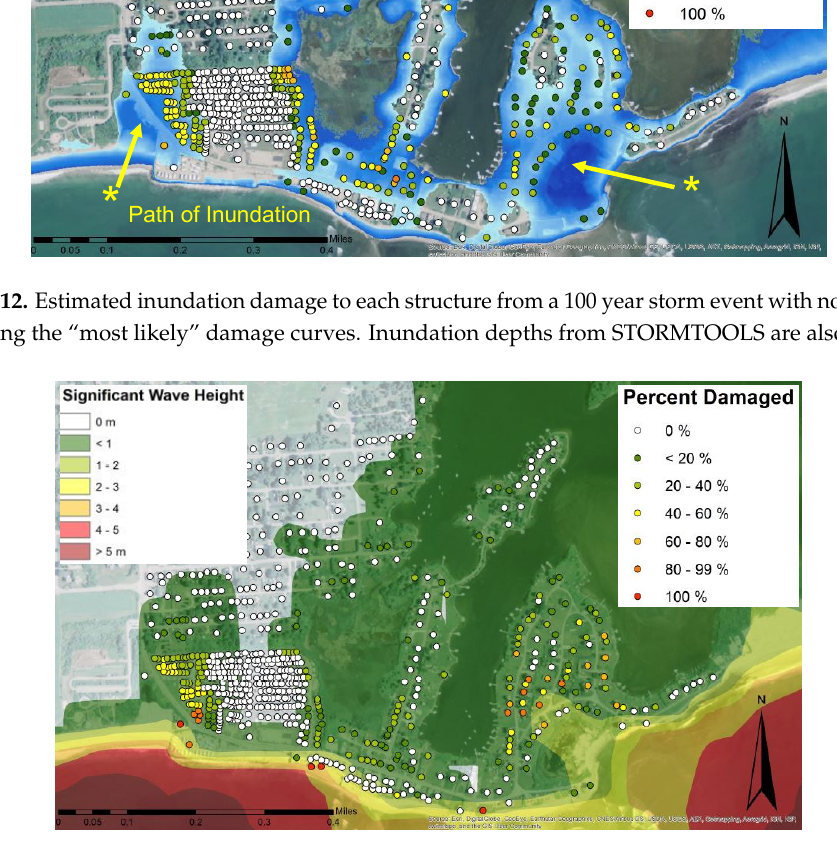
Figure 13. Estimated wave damage to each structure from a 100 year storm event with no sea level rise using the “most likely” damage curves. Wave height estimates from STWAVE are also shown.